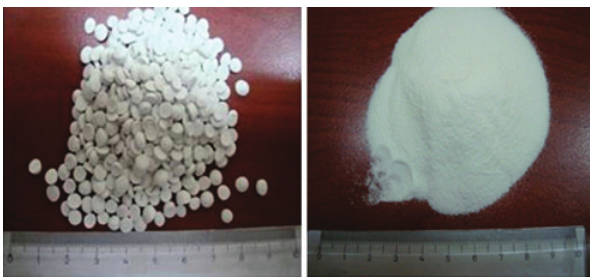
Figure 3 Granule and powder polyvinyl chloride.